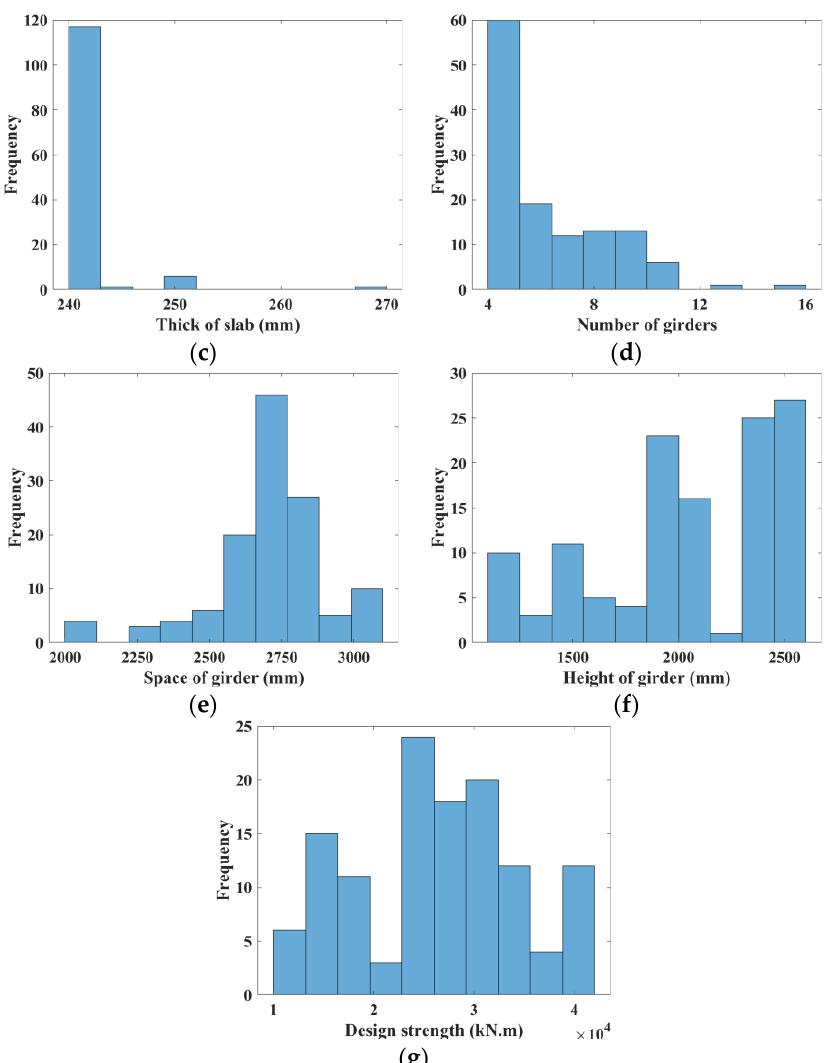
Figure 3. Distribution of data information. ( a ) Length of girder. ( b ) Width of bridge. ( c ) Thickness of